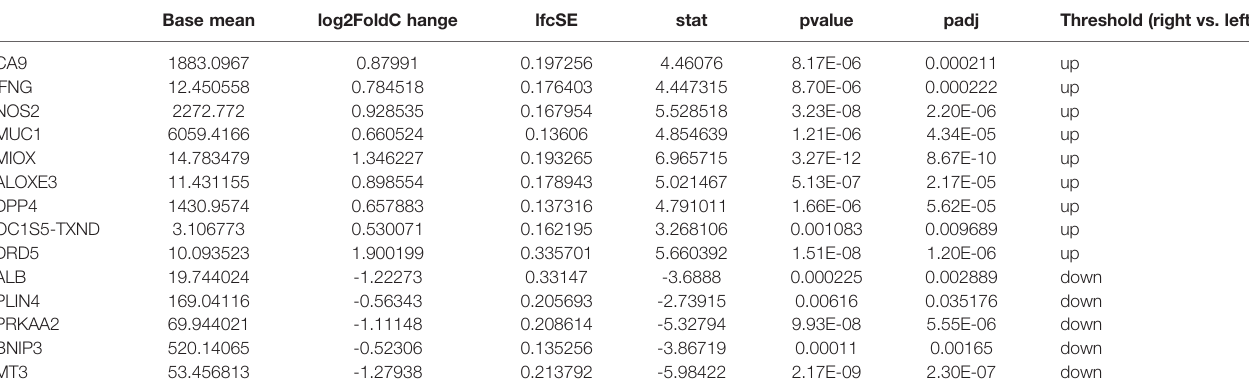
TABLE 1 | 14 DE-FRGs expression results in left- and right- colorectal cancer. Base mean log2FoldC hange lfcSE stat pvalue padj Threshold (right vs. left)